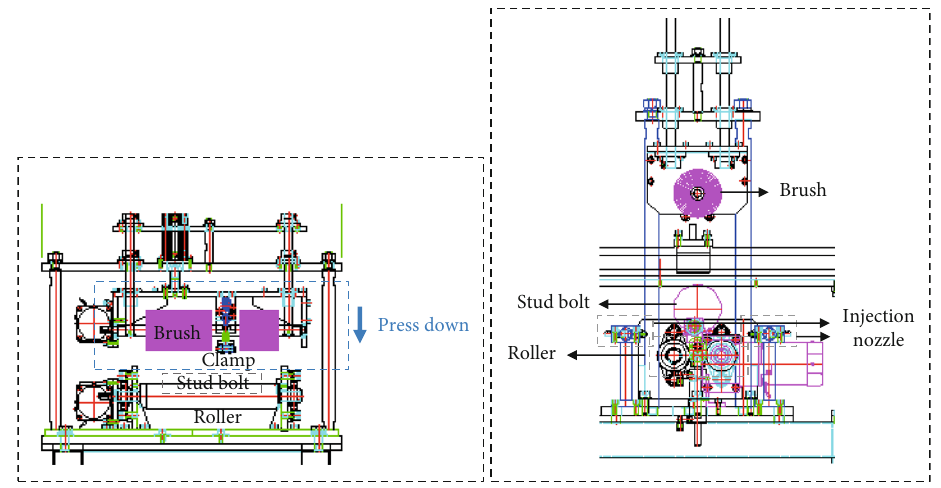
Figure 5: Detailed view of washing part (step 2): (a) side view and (b) front